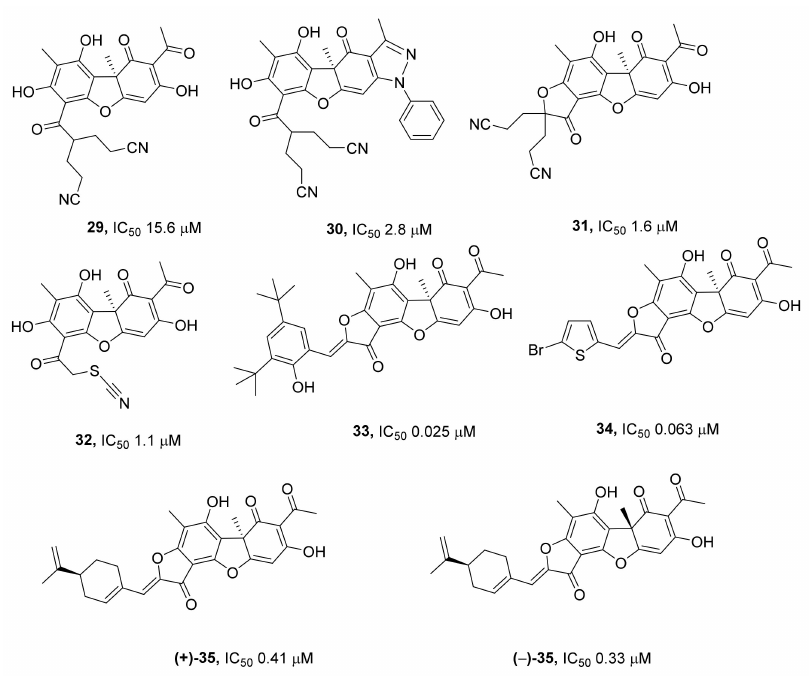
Figure 9. Cyano and furanone derivatives of usnic acid as inhibitors of